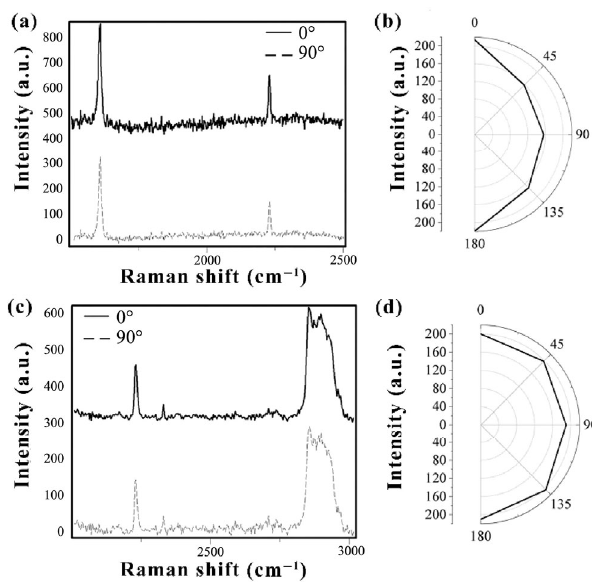
Fig. 9 In situ Raman spectral results of Lubricant 1–4 at different areas and the measured film thickness at the center